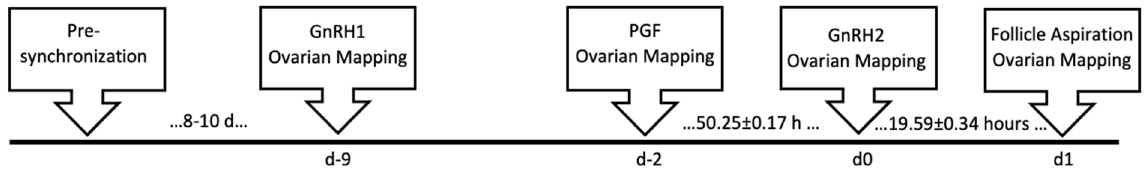
Figure 5. Timeline for synchronization of pre-ovulatory follicle development. GnRH1, gonadotropin releasing hormone administration to turn over a new follicular wave at the onset of synchronization; PGF, prostaglandin F2 α ; GnRH2, gonadotropin releasing hormone administration to induce the pre-ovulatory gonadotropin surge .